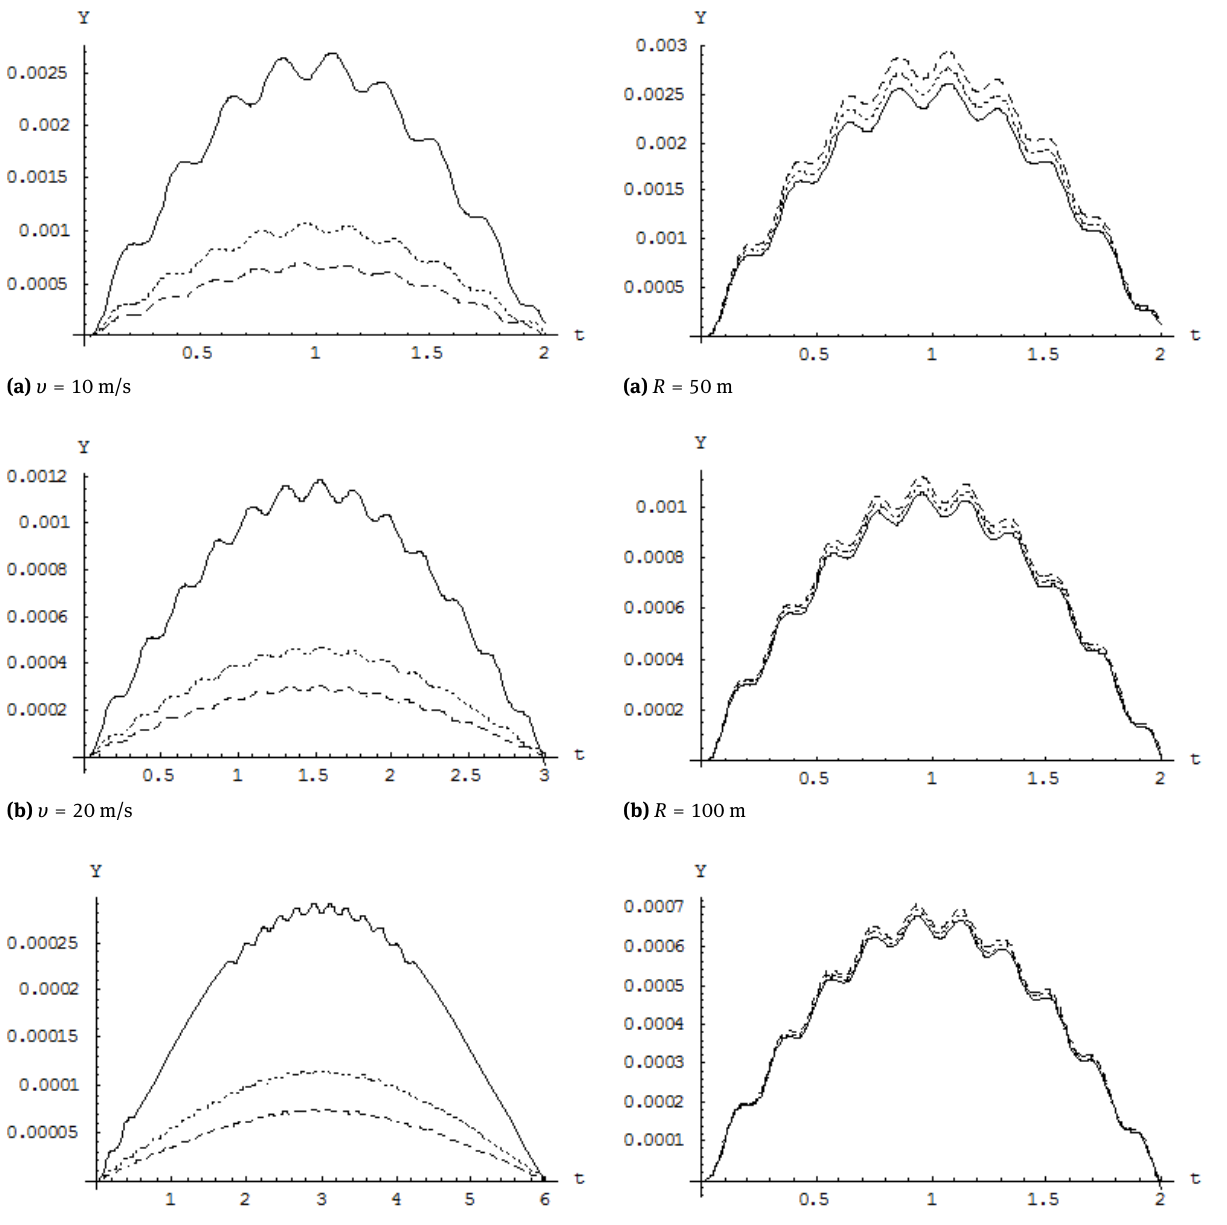
Figure 6: The influence of the radius of curvature for various values of υ : ___ R = 50 m, ...... R = 100 m, - - - R = 150 m.